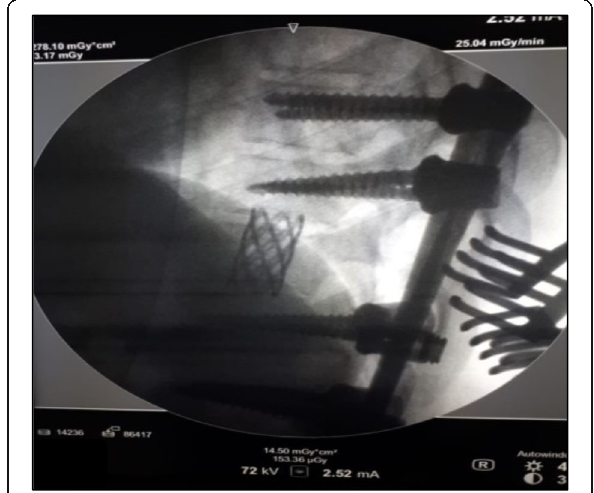
Fig. 2 Intraoperative fluoroscopy showing the placement of the